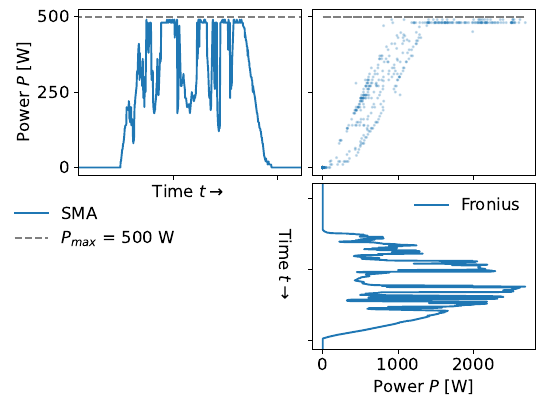
Figure 14. Data from the power limit